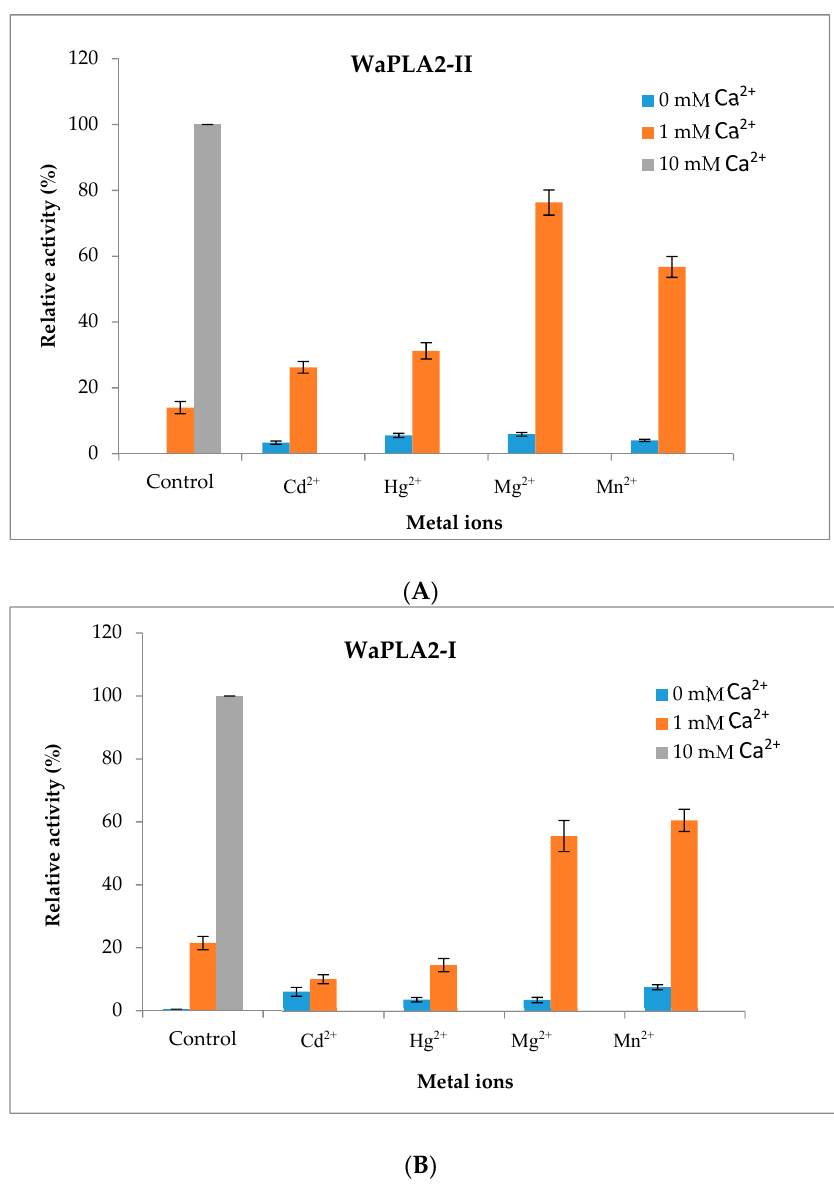
Figure 5. The effects of various metal ions on the activity of purified Wa PLA 2 -II ( A ) and Wa PLA 2 -I ( B ). The influence of metal ions (10 mM each) on the activity of each enzyme, in the absence or presence of 1 mM Ca 2 + , was studied in the presence of 4 mM NaTDC using PC emulsion as a substrate at 55 ◦ C and pH 9.5 for WaPLA 2 -II and 45 ◦ C and pH 8.5 for Wa PLA 2 -IA. The control represents 100% of sPLA2 activity at 8 mM Ca 2 + under the same conditions. The results represent the means of three independent experiments and expressed as the mean ± SD (n = 3).